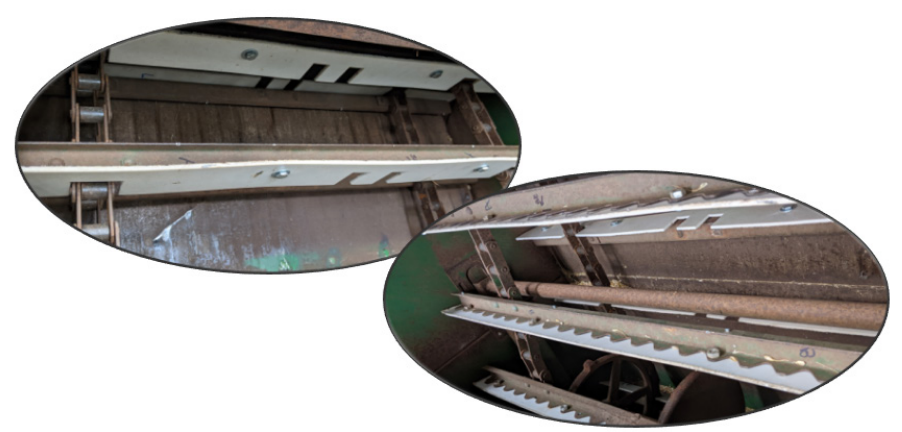
Figure 6. Feeder house paddle concept implementation showing the custom-made paddles being fastened to the leading edge of the channel section bars of the feeder